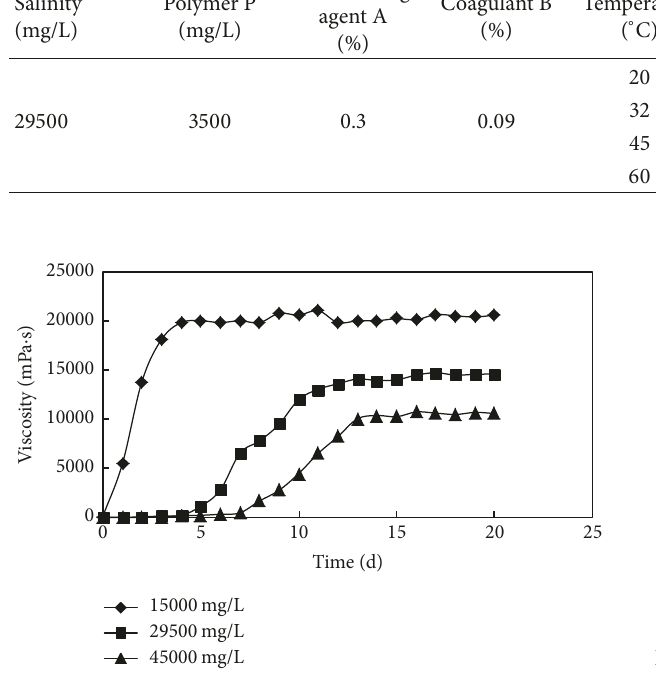
Figure 4: The changing process of viscosity at different salinities.